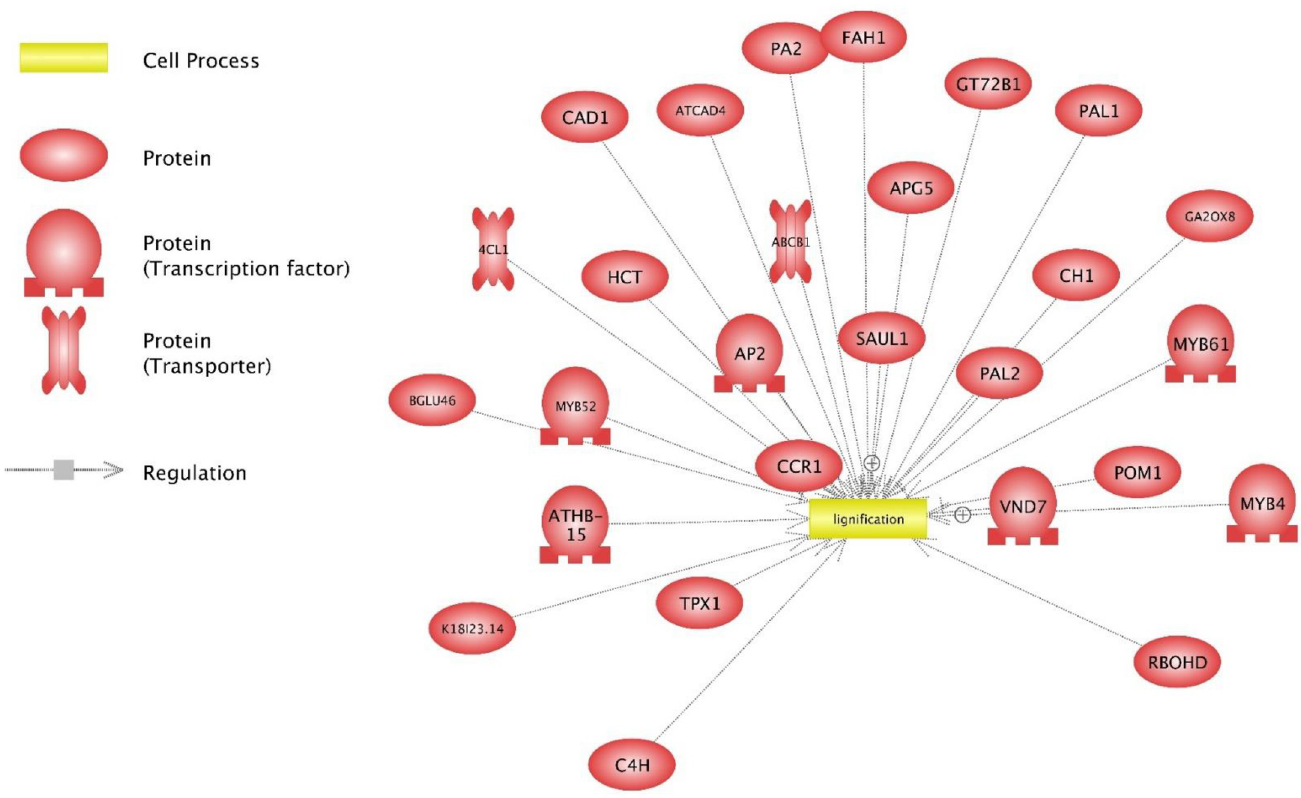
Fig 3. Proteins/chemicals regulating cellular processes of lignification. Illustration of up-regulated significant genes in Ames 21789 and their interaction with the lignification network. Visualized using Pathway Studio.